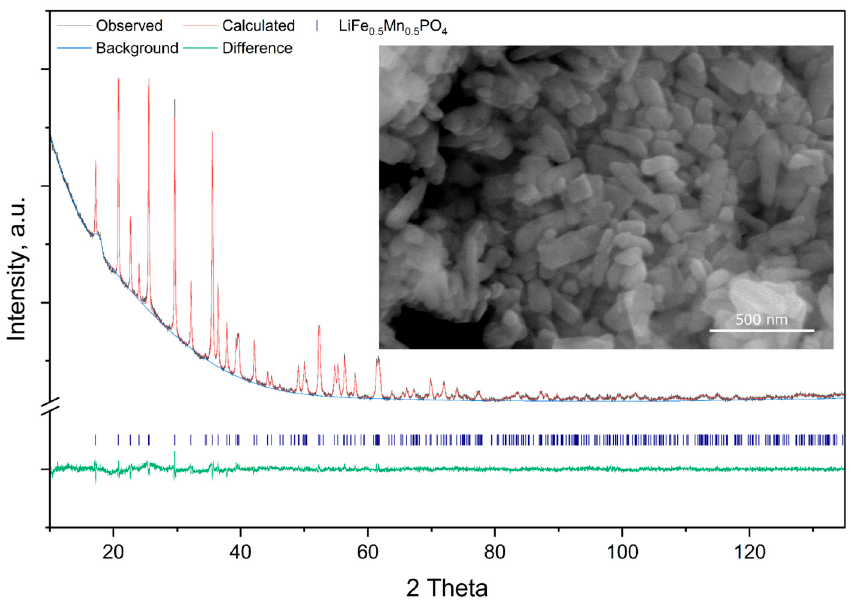
Figure 2. Rietveld refinement of the XRD pattern of the as-prepared LFMP. Inset: SEM image of the as-prepared material. Table 2. Mass change and determined carbon content values for Glu and PAN Table 1. Unit cell parameters determined from the PXRD refinement.